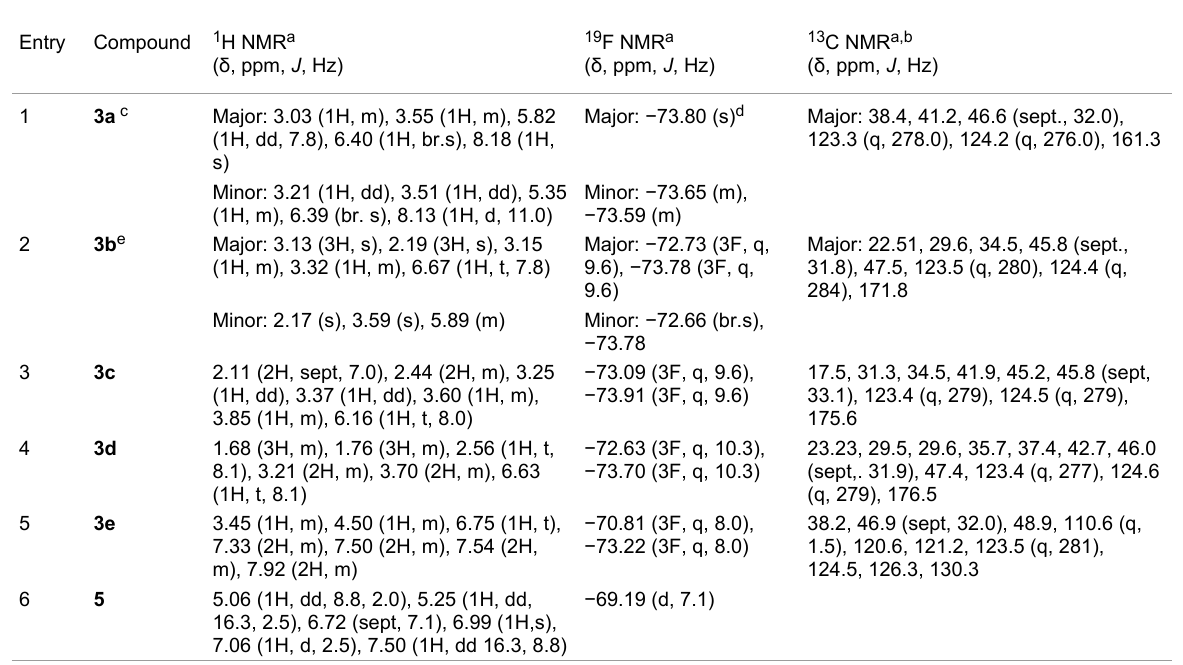
Table 2: 1 H, 19 F, 13 C NMR data for compounds 3a–e and 5